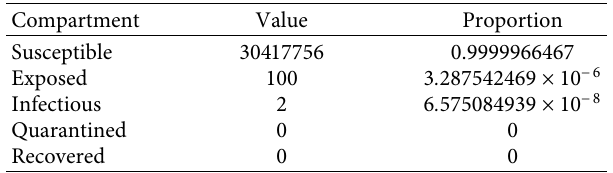
Table 4: Initial conditions for the fve subgroups of the population size of Ghana.